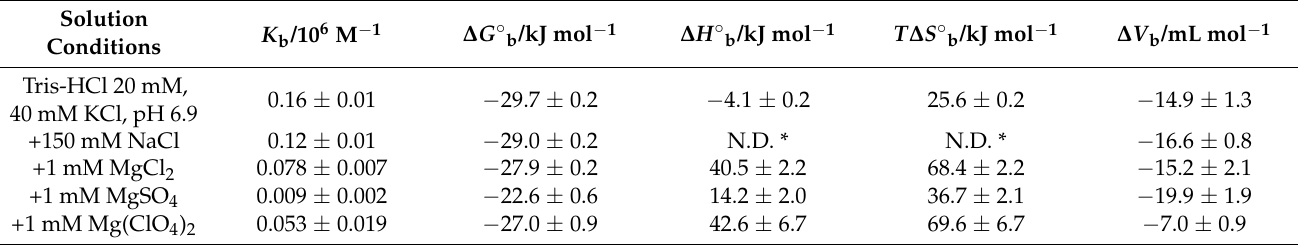
Table 3. Binding constants, K b , for tRNA–ThT complex formation in 20 mM Tris-HCl buffer, 40 mM KCl, pH 6.9, in the absence and in the presence of the indicated salts at the temperature of 25 ◦